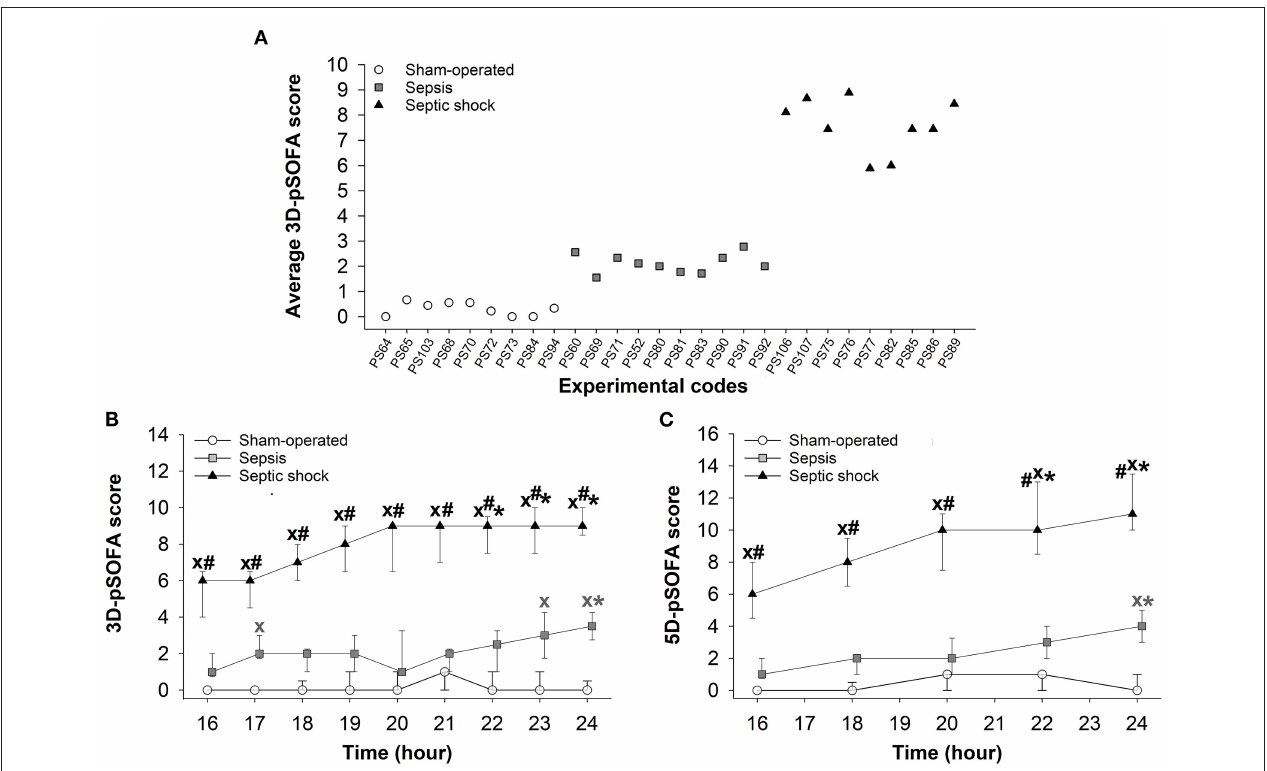
FIGURE 2 | Average values for basic pSOFA scores in individual animals during the 8-h invasive monitoring period (during t = 16–24h) (A) in the sham-operated group (open circles) and the sepsis (gray square) and septic shock subgroups (black triangle). Changes in 3D-pSOFA (B) and 5D-pSOFA (C) values as a function of time in the sham-operated group and the sepsis and septic shock subgroups. The plots demonstrate the median values and the 25th (lower whisker) and 75th (upper whisker) percentiles. X P < 0.05 vs. sham-operated group; # P < 0.05 vs. sepsis group; * P < 0.05 vs. t =